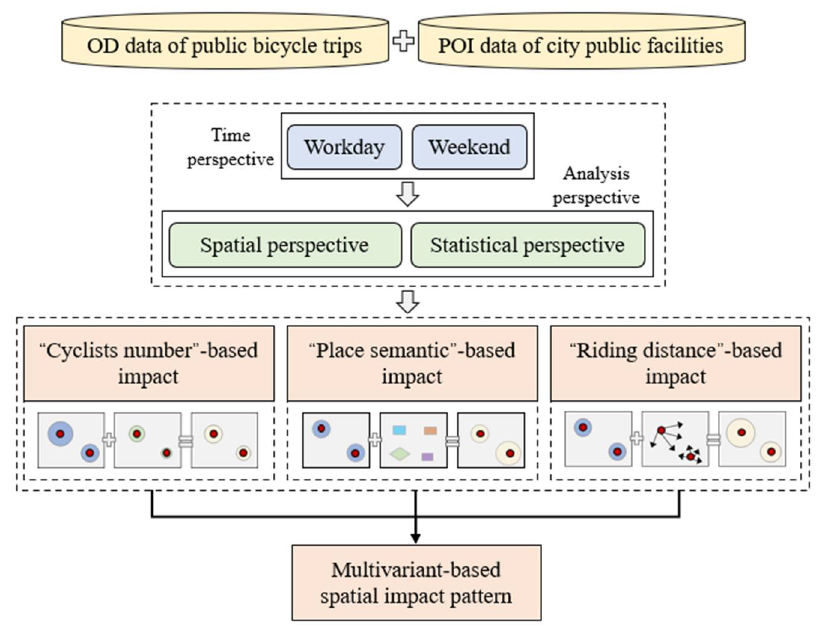
Figure 3. Research framework of the